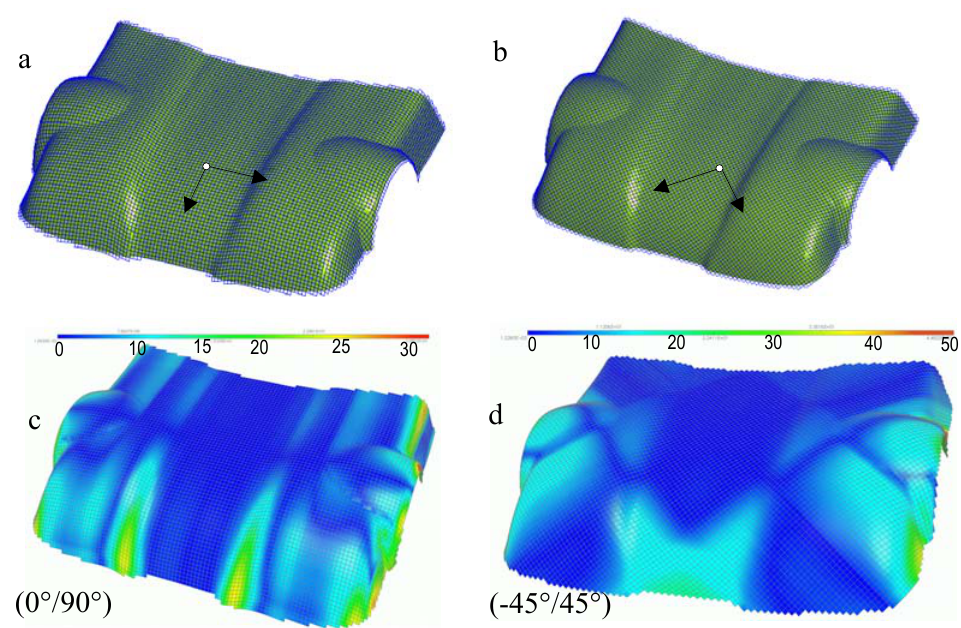
Figure 18. Geometrical draping of a car hood part and iso-values of shear